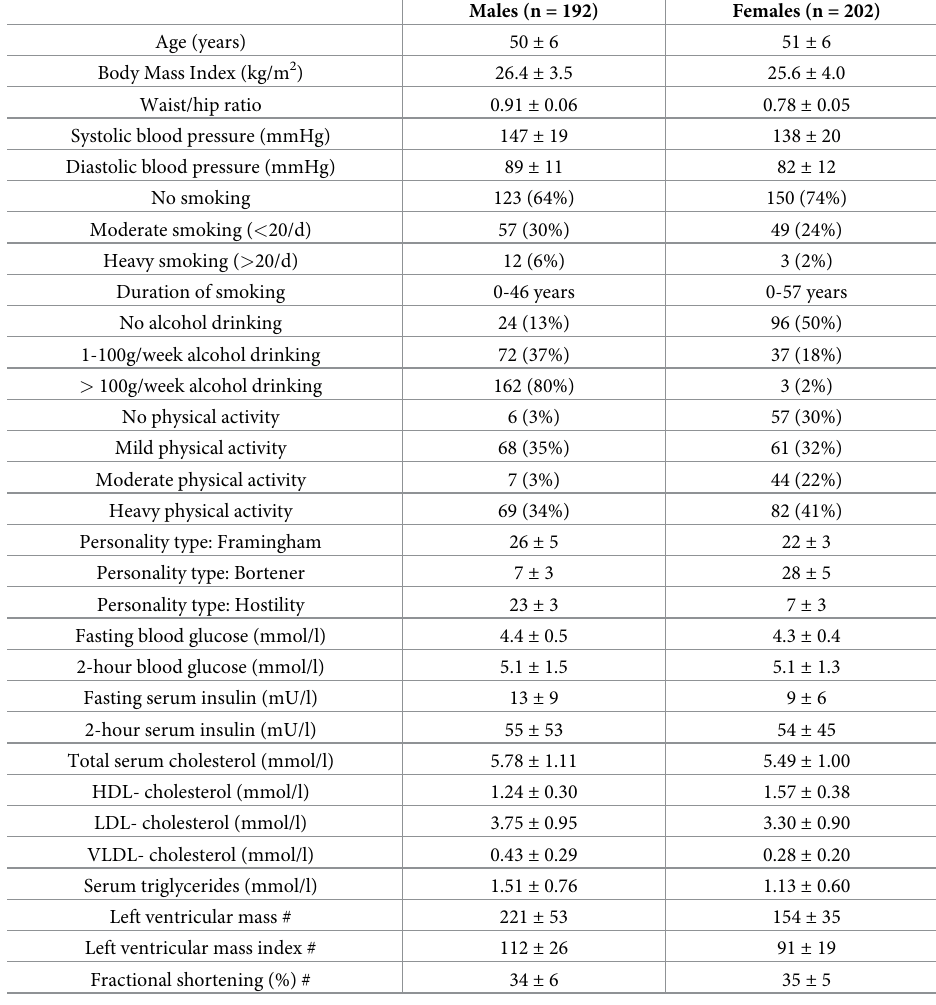
Table 5. Clinical, lifestyle and laboratory characteristics of the population used in [34].